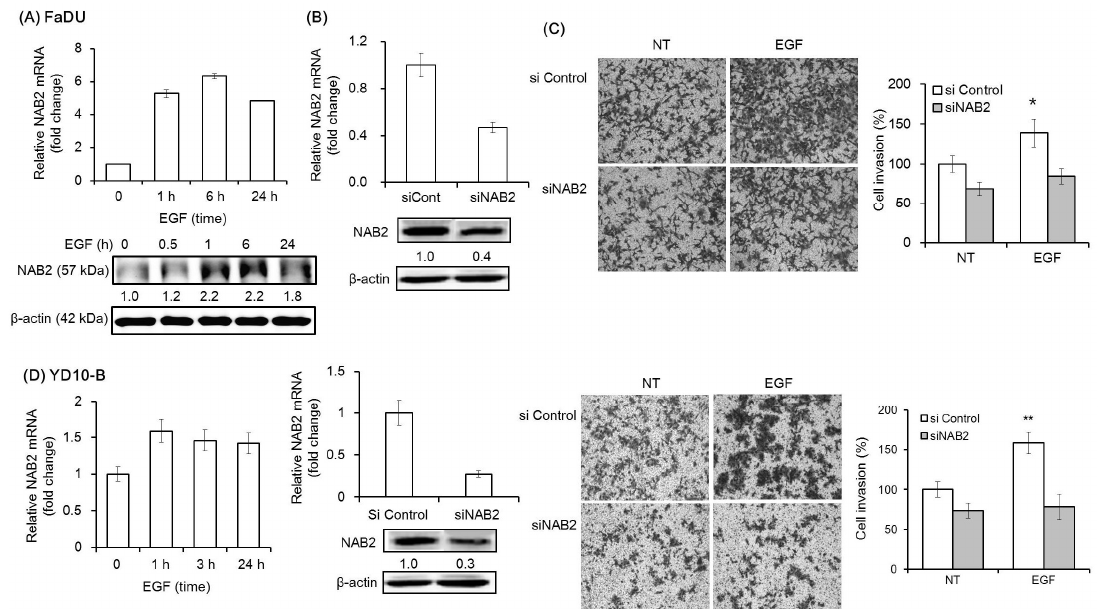
Figure 2. Effect of NAB2 on EGF-dependent head and neck squamous cell carcinoma (HNSCC) cell invasion. ( A ) NAB2 mRNA and protein expression following EGF treatment (50 ng/mL) for 24 h was analyzed in FaDU cells by qPCR and Western blot analysis. ( B ) FaDU cells were transfected with an siNAB2 mixture (40 nm/mL) for 48 h, after which the mRNA and protein expression of NAB2 were analyzed. ( C ) Two-dimensional Transwell Matrigel invasion assays were performed to analyze the effect of NAB2 knockdown, followed by EGF treatment, on FaDU cell invasion. Control siRNA- or siNAB2-transfected FaDU cells were added to each Matrigel-coated Transwell. After culturing for 48 h, the cells were washed twice with phosphate-bufferd saline and stained with 0.2% crystal violet in 10% ethanol (5× magnification). The cell invasion index was calculated as the difference between the number of invading cells in the siNAB2-transfected group compared to that in the control siRNA-transfected group (* p < 0.01). ( D ) Matrigel invasion assays using YD-10B cells were performed with the same conditions (5× magnification) (** p < 0.005). The results shown are from two or three independent experiments, with each bar representing the standard deviation.